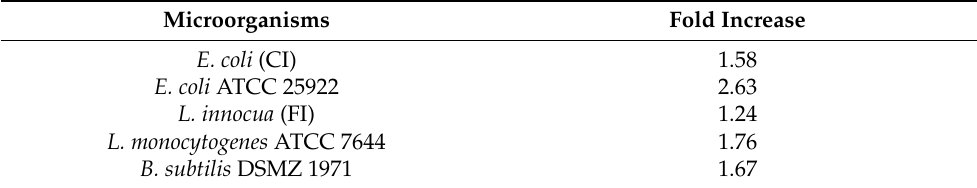
Table 3. The fold increases in biofilm formation in response to AFAq.